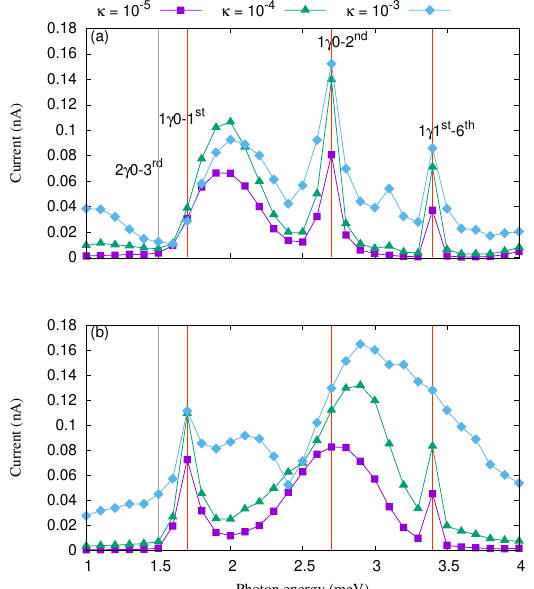
Figure 4. Current versus the photon energy for the cavity–reservoir coupling κ = 10 − 5 meV (purple squares), 10 − 4 (green triangles), and 10 − 3 (blue diamonds) in the case of x - ( a ) and y -polarized ( b ) photon field with g γ = 0.1 meV, and n R = 1. The vertical red lines indicates the positions of the resonance states. The chemical potential of the leads are µ L = 1.65 meV, and µ R = 1.55 meV. The external weak magnetic field is B = 0.1 T, eV g = 0.651 meV, T L,R = 0.5 K, and ¯ h Ω 0 = 2.0